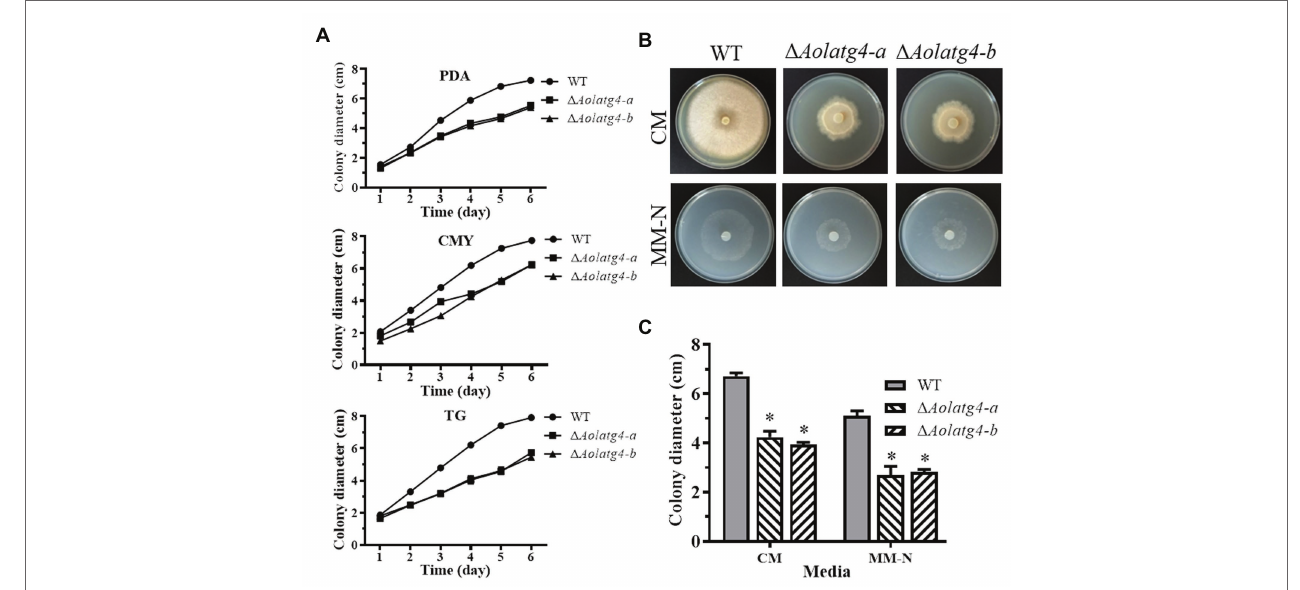
FIGURE 1 | Comparison of mycelial growth of the wild type (WT) and ΔAolatg4 mutants on different meida. (A) Colony diameters of fungal strains incubated on potato dextrose agar (PDA), CMY, and tryptone glucose (TG) media. Each experiment was performed three times. (B) Colony morphology of fungal stains incubated on CM and MM-N media at 28 ° C for 7 days. (C) Colony diameters of fungal strains incubated on CM and MM-N plates for 7 days. Error bars: standard deviation, asterisk: significant difference between mutant and WT (Tukey’s HSD, p <